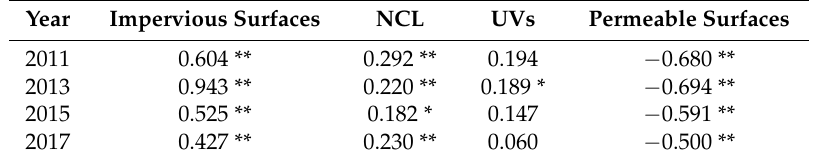
Table 6. Pearson’s correlation coefficients of surface temperature and area ration of different land-use types.